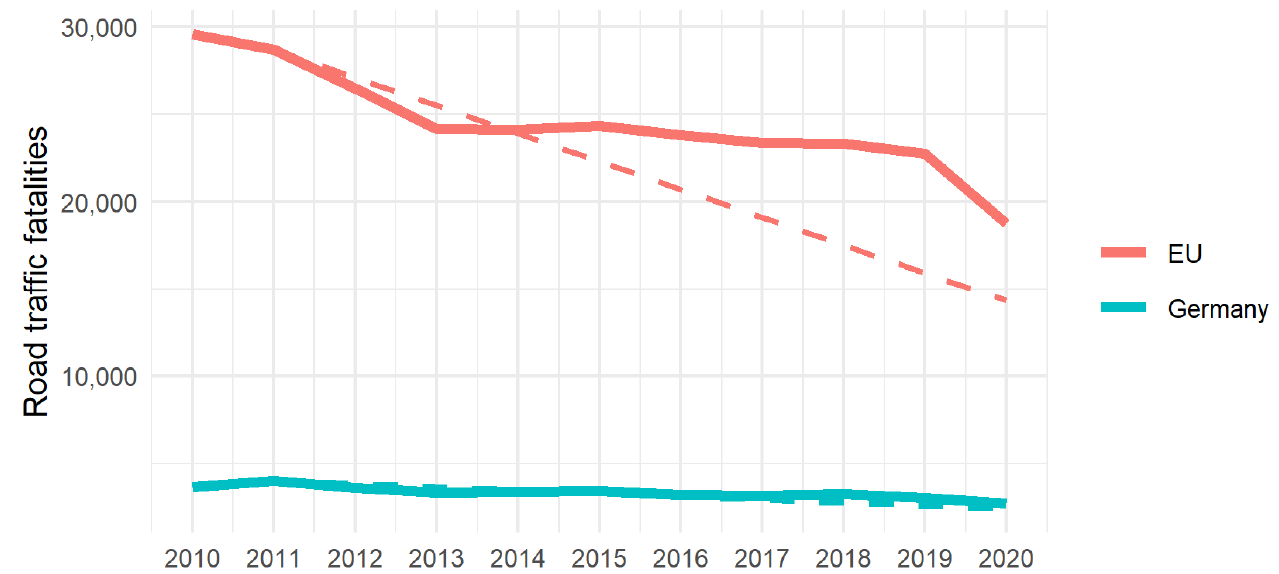
Figure 1. Number of fatal collisions in the EU and Germany from 2001 to 2020 (dottet lines = inter- mediate goal for reaching Vision Zero; data from eurostat [9]).